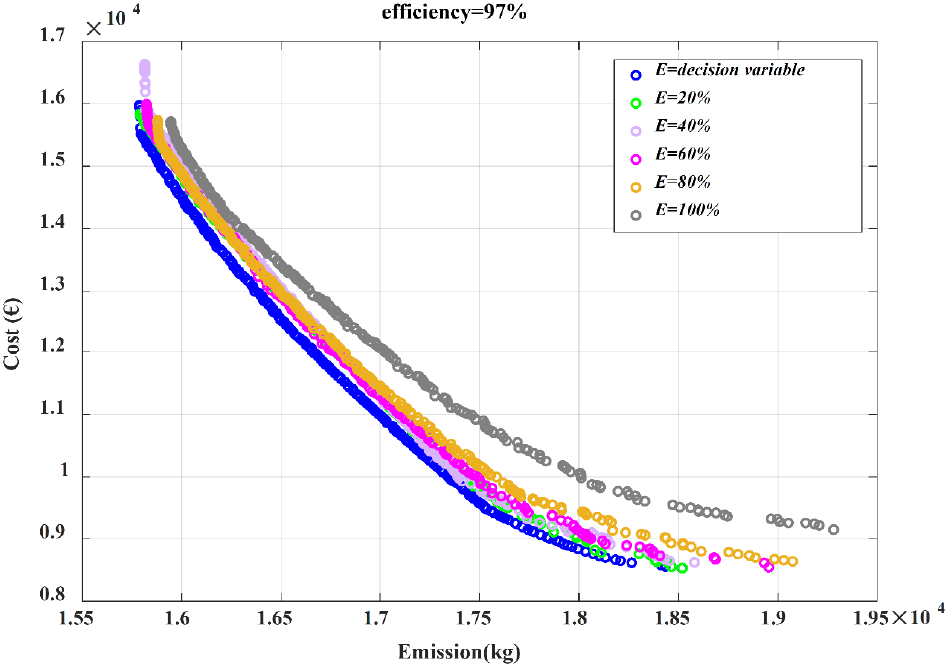
Figure 10. Pareto optimal front for different efficiencies along with their BCS points ( E = 100%). Figure 13. Comparison of Pareto optimal fronts for different E values (97% efficiency).